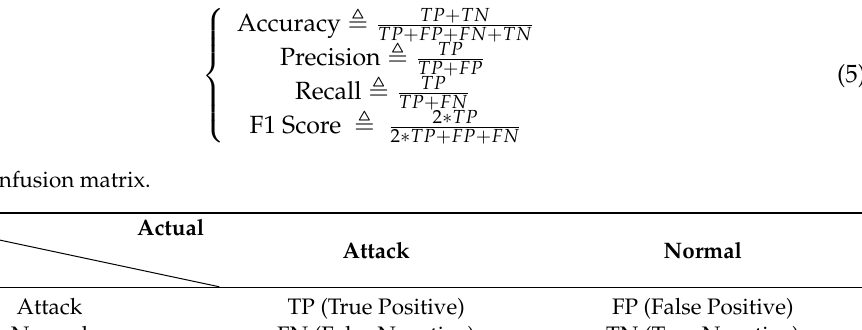
Table 2. Confusion matrix.